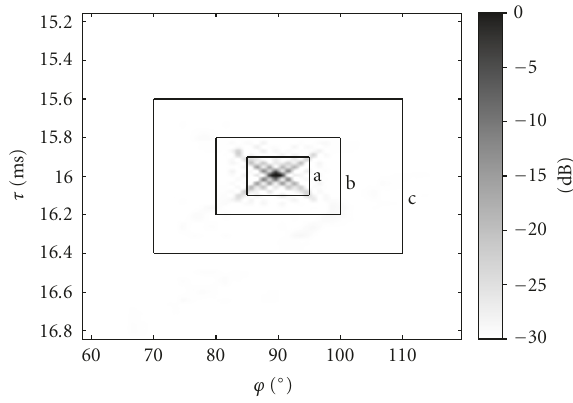
Figure 10: The model space frame for θ = 70 ◦ (see Figure 9(d)), zoomed in on the representation of the wave incident under that el- evation angle. Three filter windows are shown used for the selection of data for reconstruction in the data